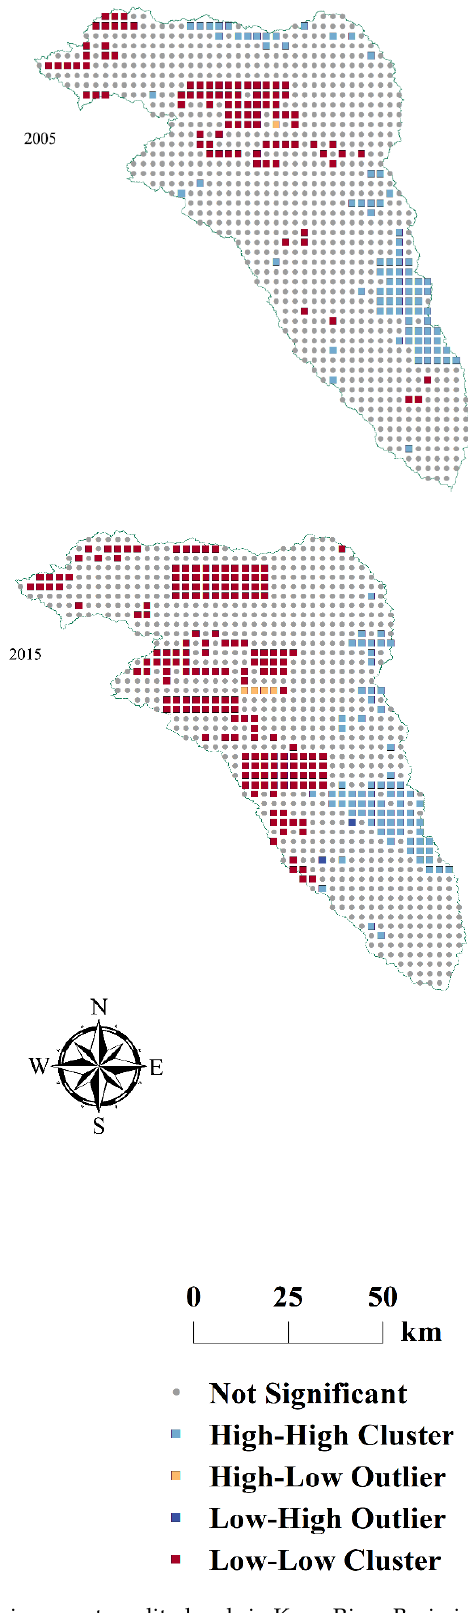
Figure 7. LISA map of the ecological environment quality levels in Kuye River Basin in 2000, 2005, 2010, 2015, and 2020 .